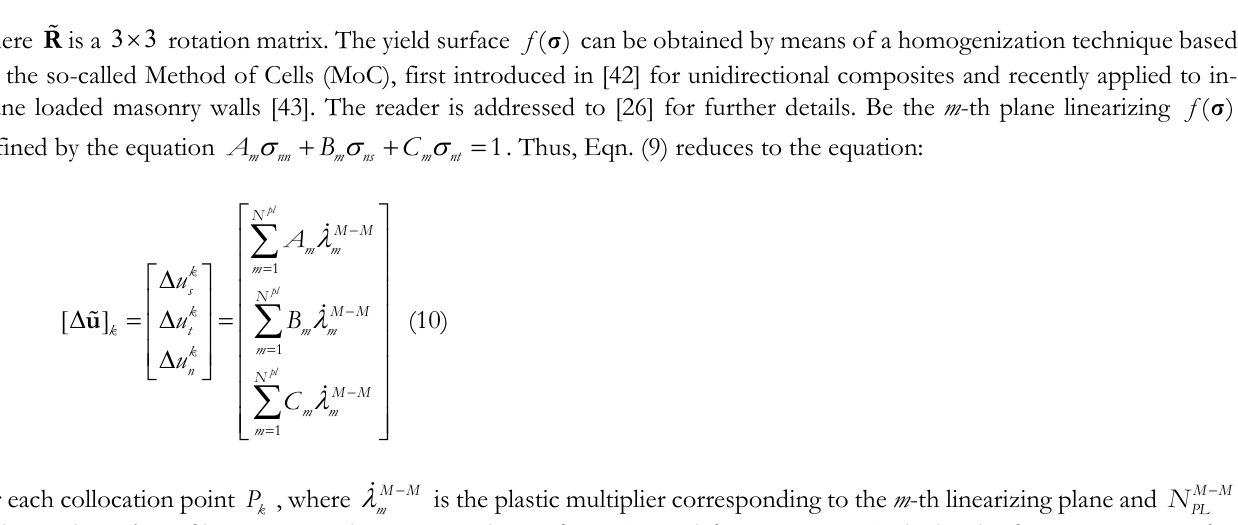
the transversal tangential unit vector. Velocity jumps